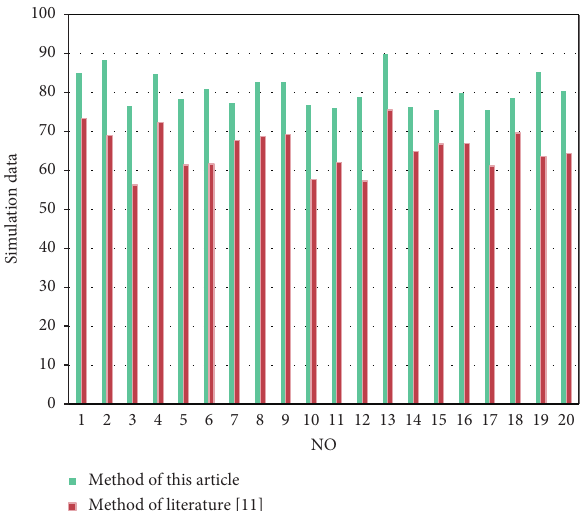
Figure 10: Music teaching effect comparative